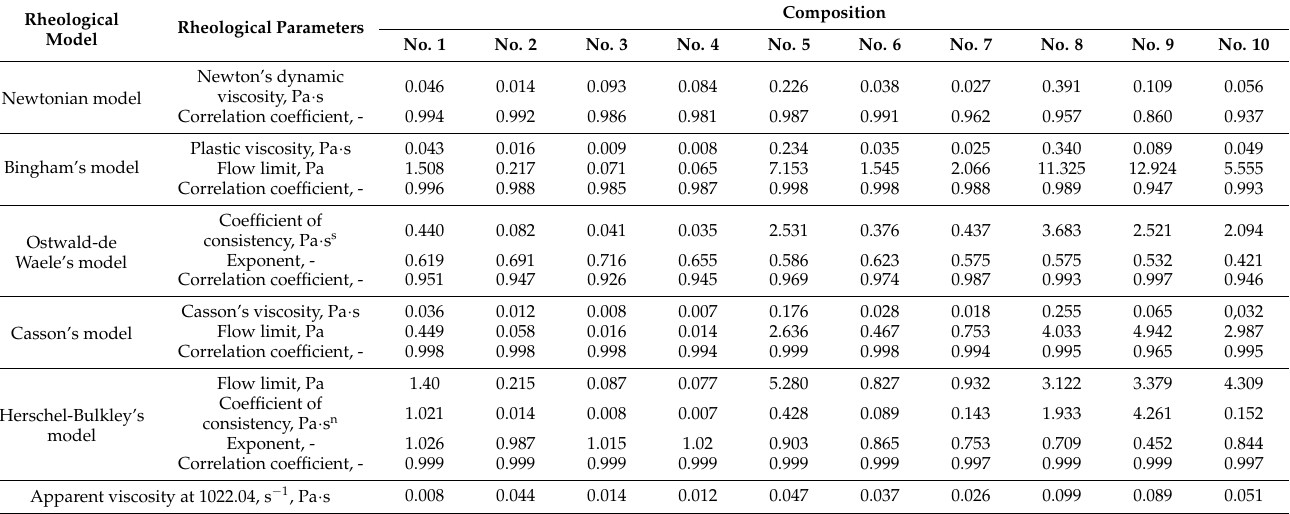
Table 3. Rheological parameters of brine cement slurries determined at 20 ◦ C for various rheological models. Rheological Rheological Parameters Model